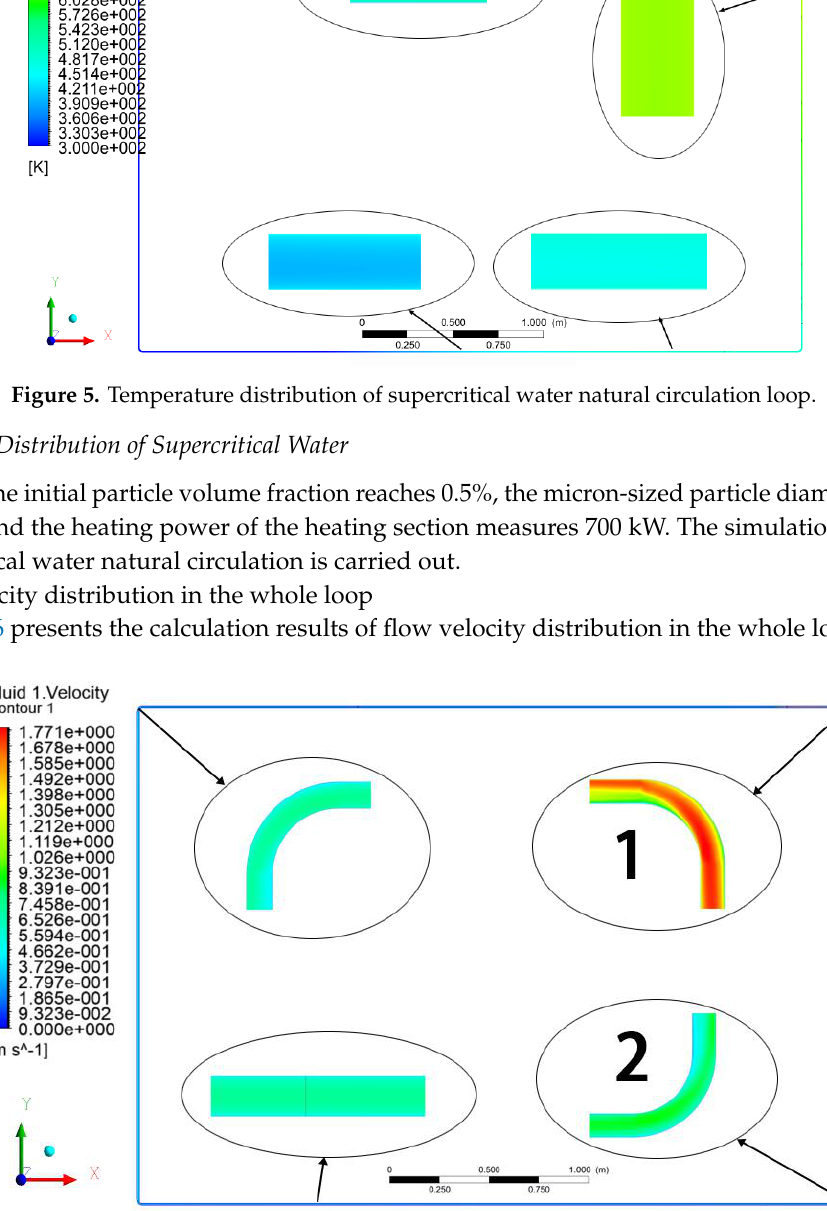
Figure 5. Temperature distribution of supercritical water natural circulation loop.